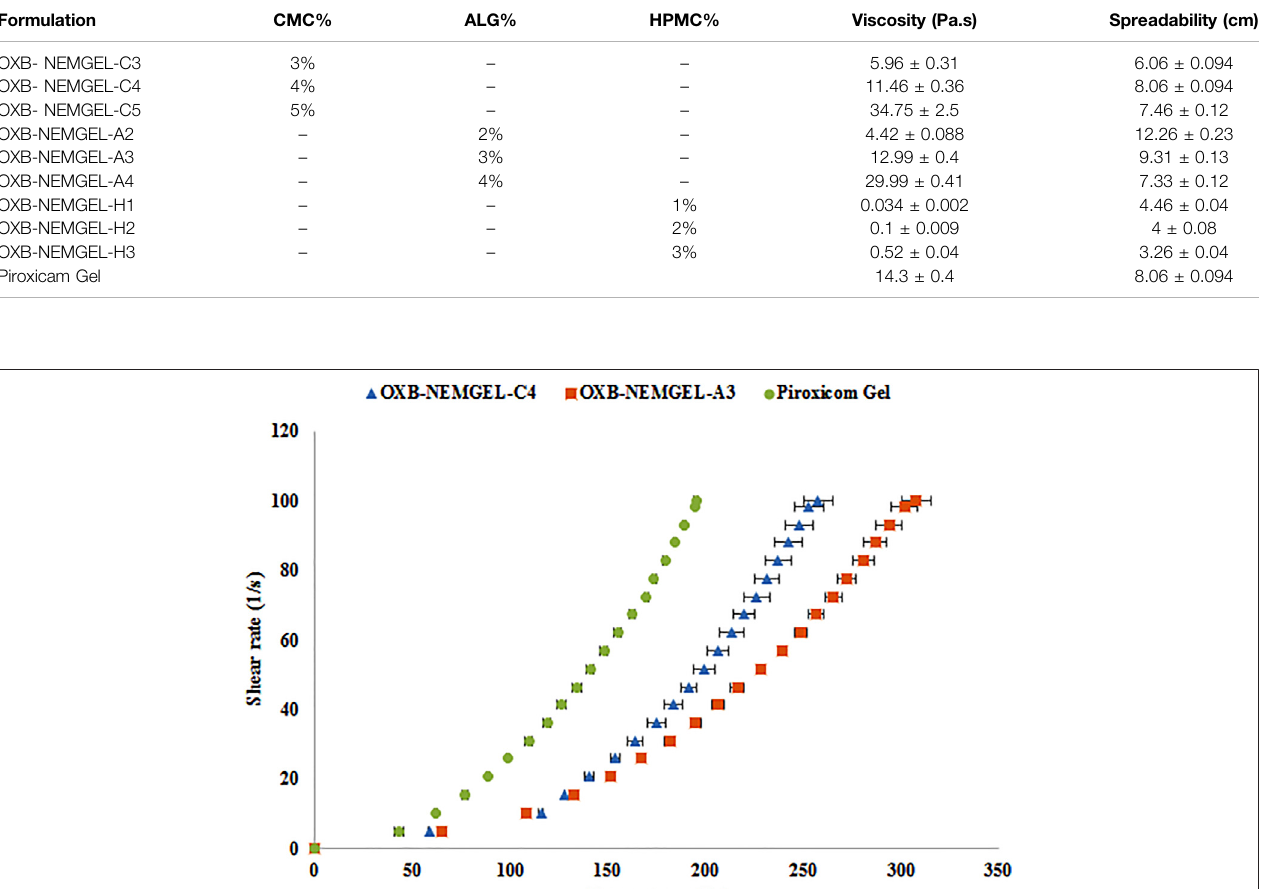
Frontiers in Materials |